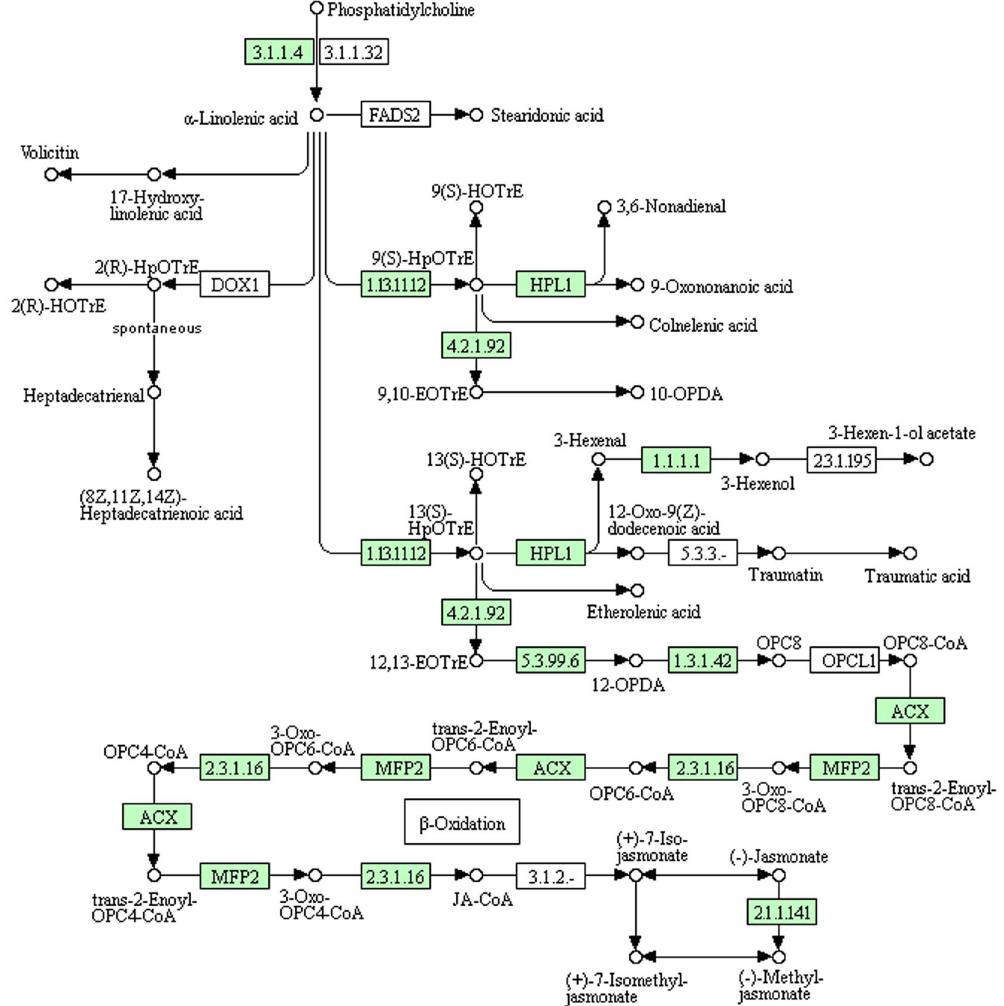
Figure 4. KEGG analysis showing genes involved in α -linolenic acid metabolism in Capparis spinosa leaf transcriptome (Enzyme Code - EC - identified are in